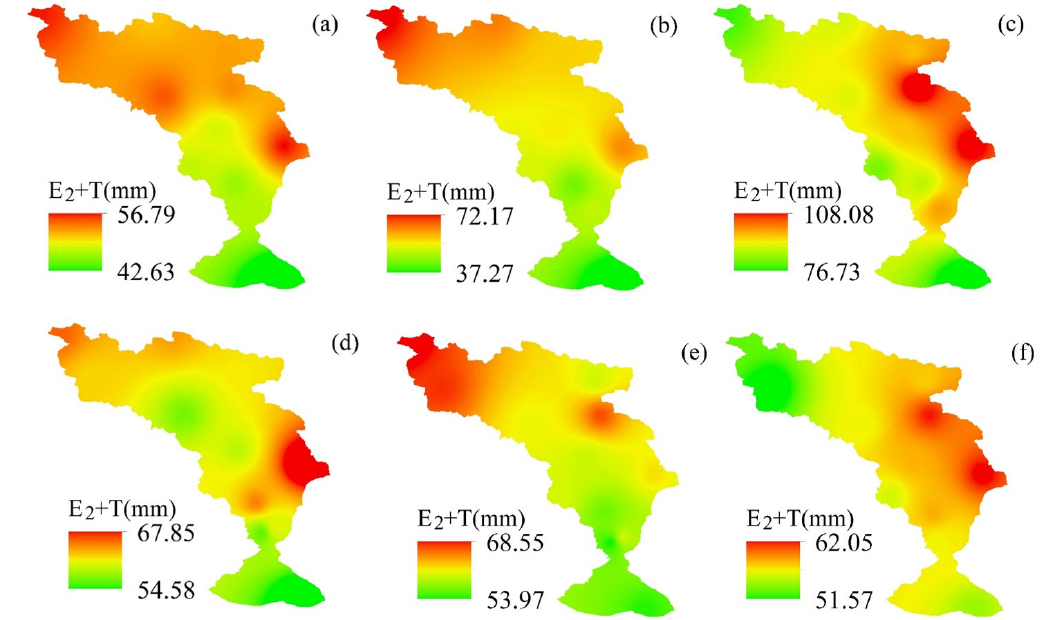
Figure 4. Spatial variation of soil fractionation values ( E 2 + T ) in summer 2018 ( a – c ) and 2019 ( d – f ).